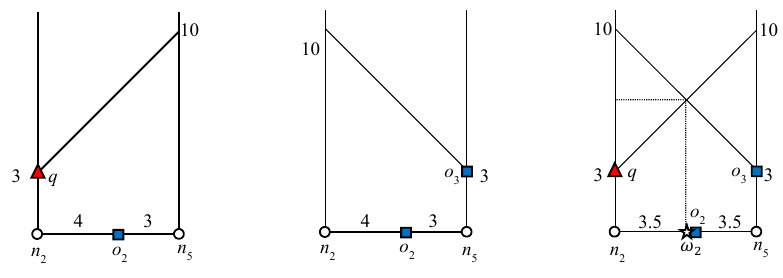
Figure 9. Determination of safe exit point ω 2 .